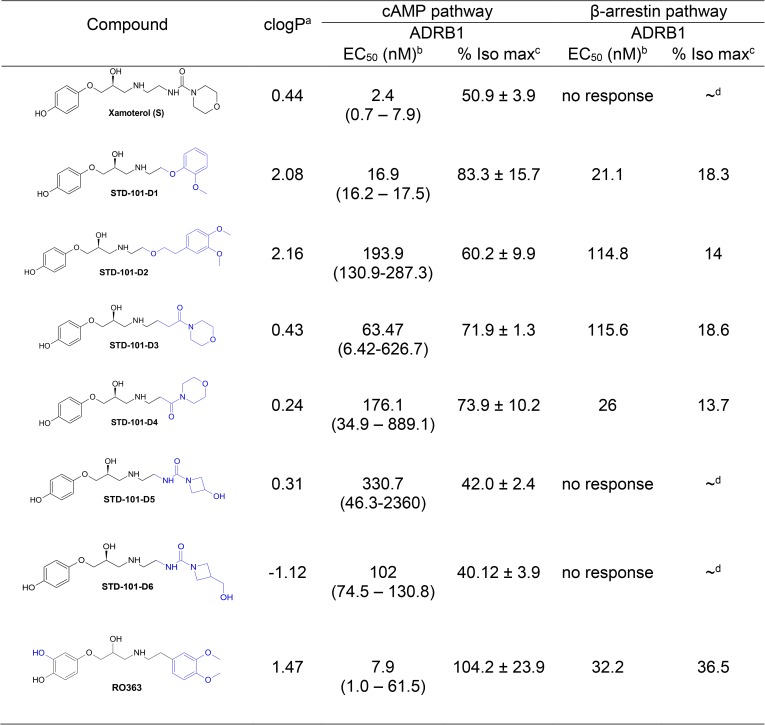
Effects of structural modifications of the morpholino urea moiety of xamoterol on the cAMP pathway mediated by ADRB1.clogPa, Calculated with ChemDraw Pro Version 16.0; EC50 (nM)b, Geometrical mean of EC50 values from at least two independent experiments; % Iso maxc, Percent efficacy compared to the maximum response achieved with isoproterenol; ~d, Could not be determined.